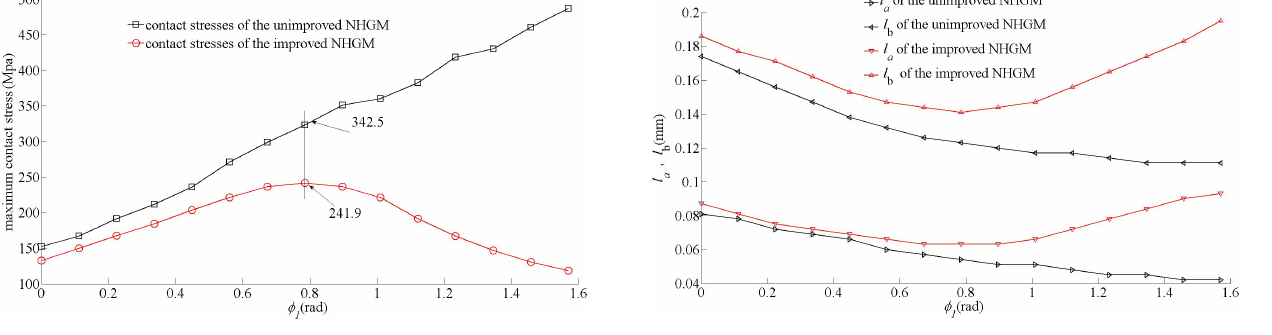
Figure 7. Maximum contact stresses of the different tooth surfaces.